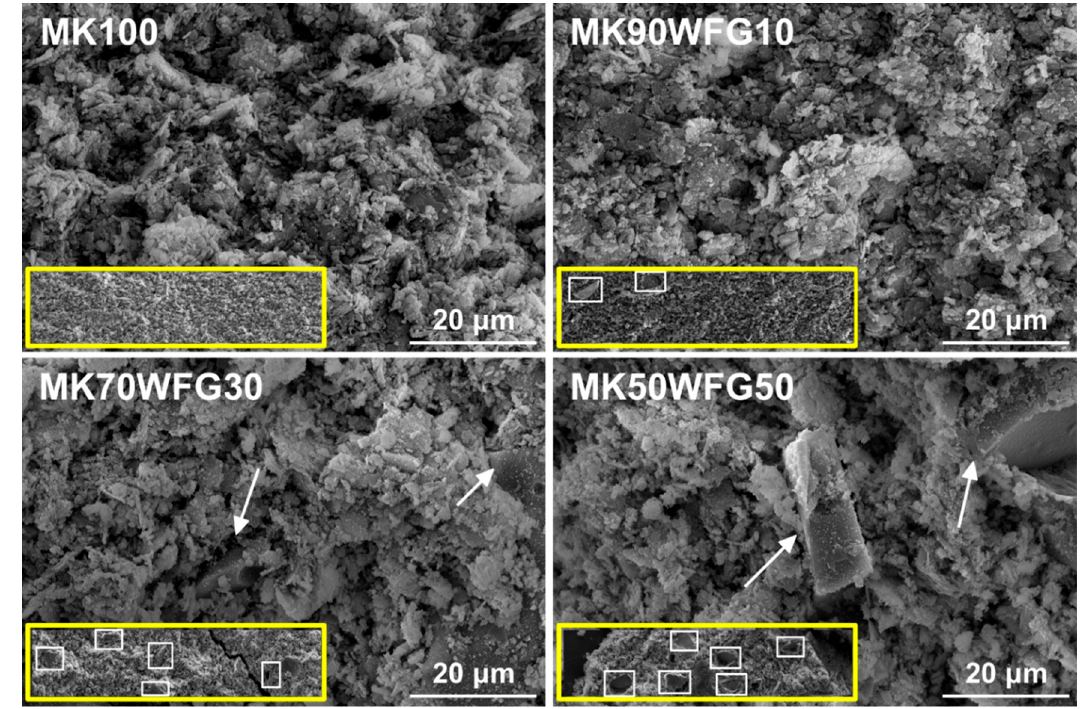
Figure 6. SEM micrographs of the produced alkali-activated materials (MK100, MK90WFG10, MK70WFG30 and MK50WFG50) at 1500× magnification (600× magnification images given as insets; WFG particles in the matrices are indicated).